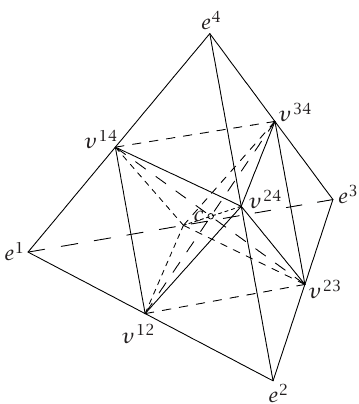
Figure 3.2 . The rational simplicial decomposition Ξ ∗ of ∆ for n = 4, r = 1. of P 1